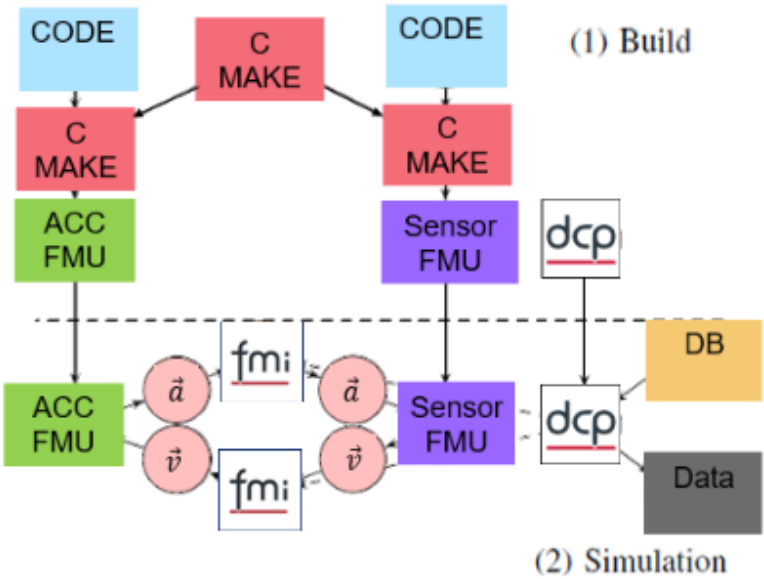
Figure 3. The graph from Figure 2 represented with different components and tools.